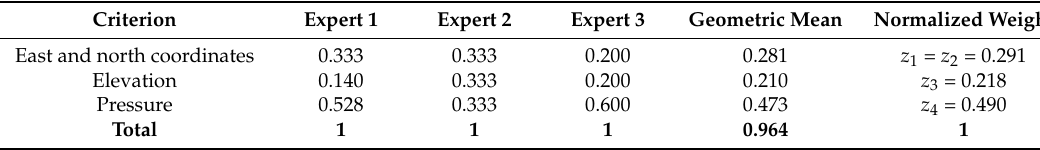
Table 6. Normalized weight of each